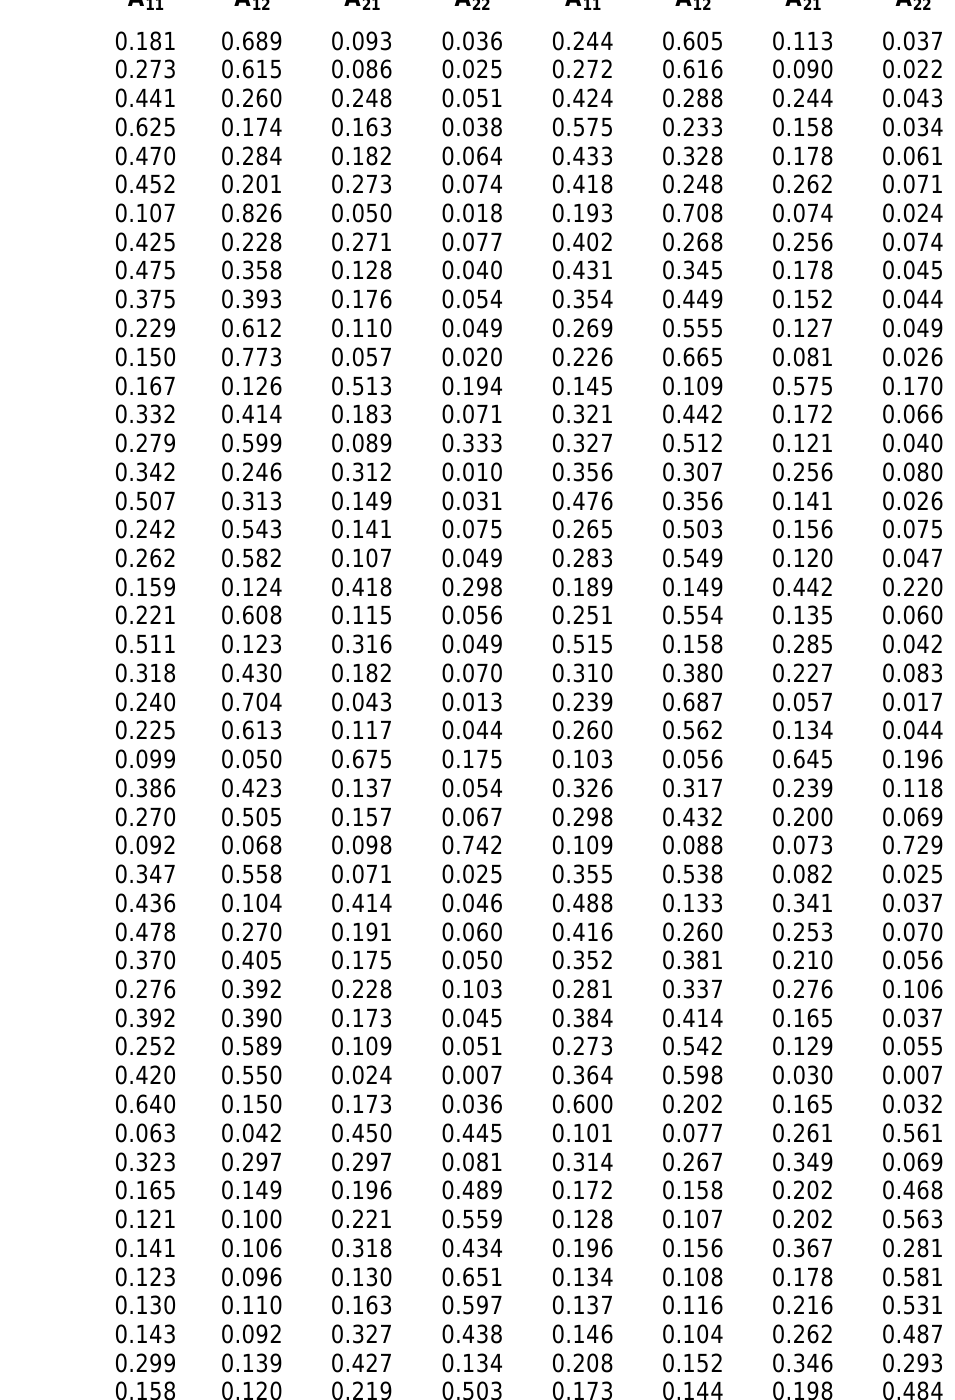
Membership Degrees of the Cardiac Patients to the Classes of the Final Fuzzy Hierarchical Partition, without and with Data